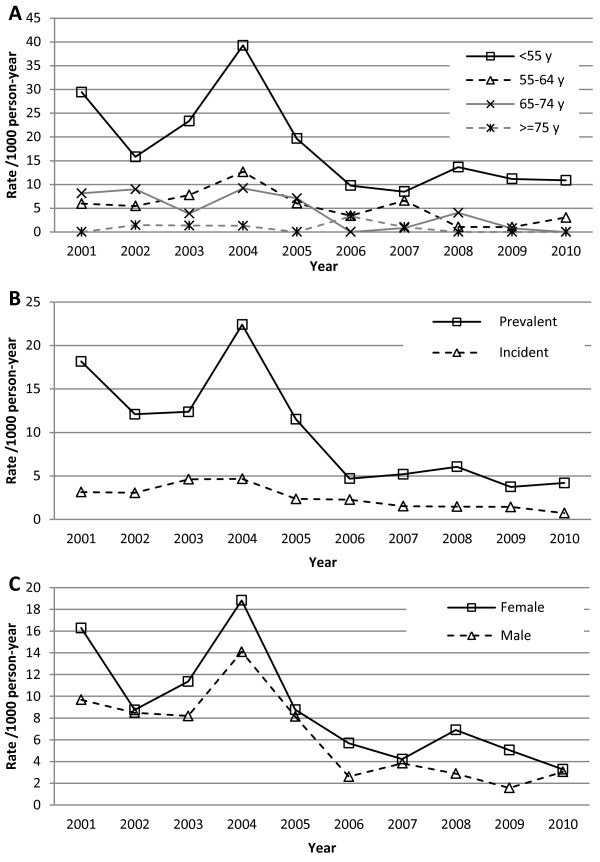
Parathyroidectomy rates by age, sex, and incidence/prevalence. Panel A. Parathyroidectomy rates by age categories. Age is calculated at cohort entry. Panel B. Parathyroidectomy rates by sex. Panel C. Parathyroidectomy rates for incident and prevalent patients. See text for definition of incident patients. Abbreviations: PTX, parathyroidectomy; py, person-year.